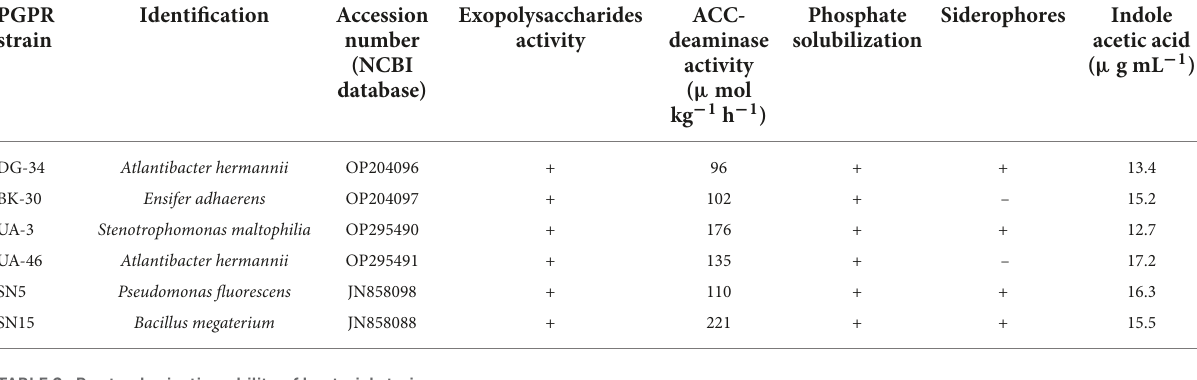
TABLE 2 Root colonization ability of bacterial strains. Bacterial strains DG-34 Root colonization (cfu g − 1 )